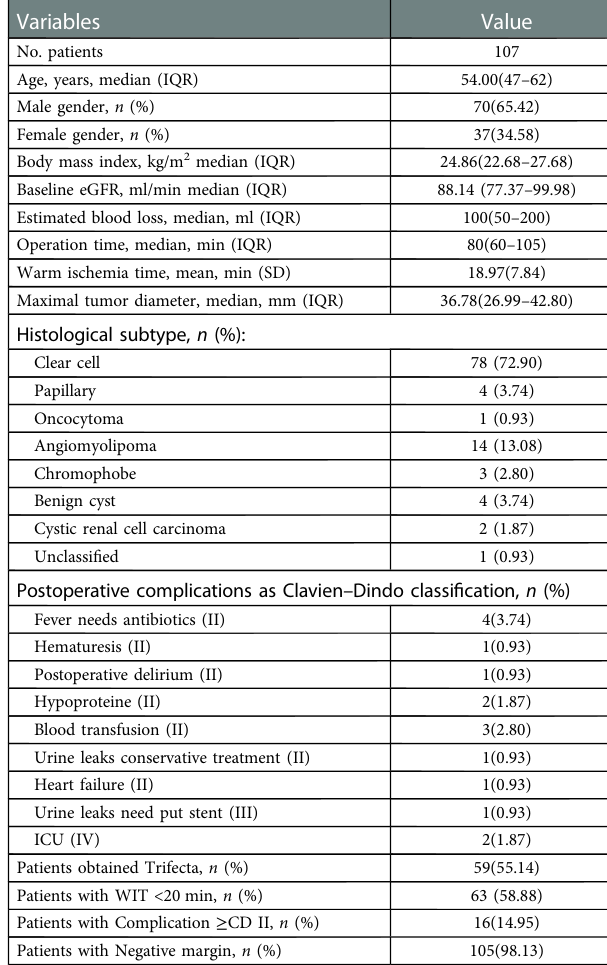
TABLE 1 demography and perioperation feature of the 107